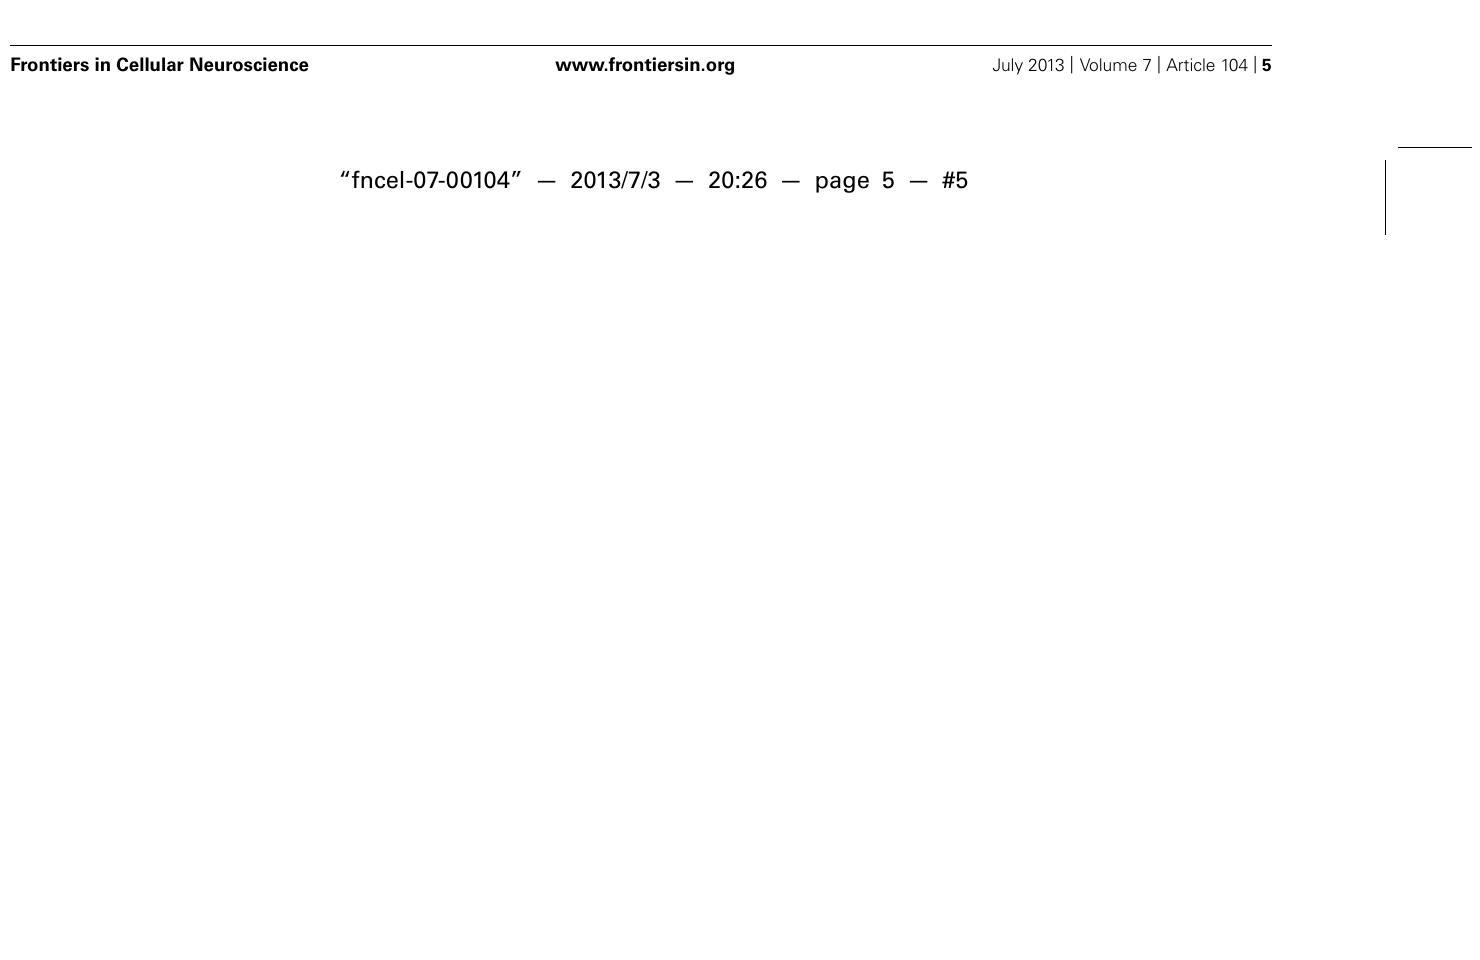
by spatial buffering of potassium and by taking up